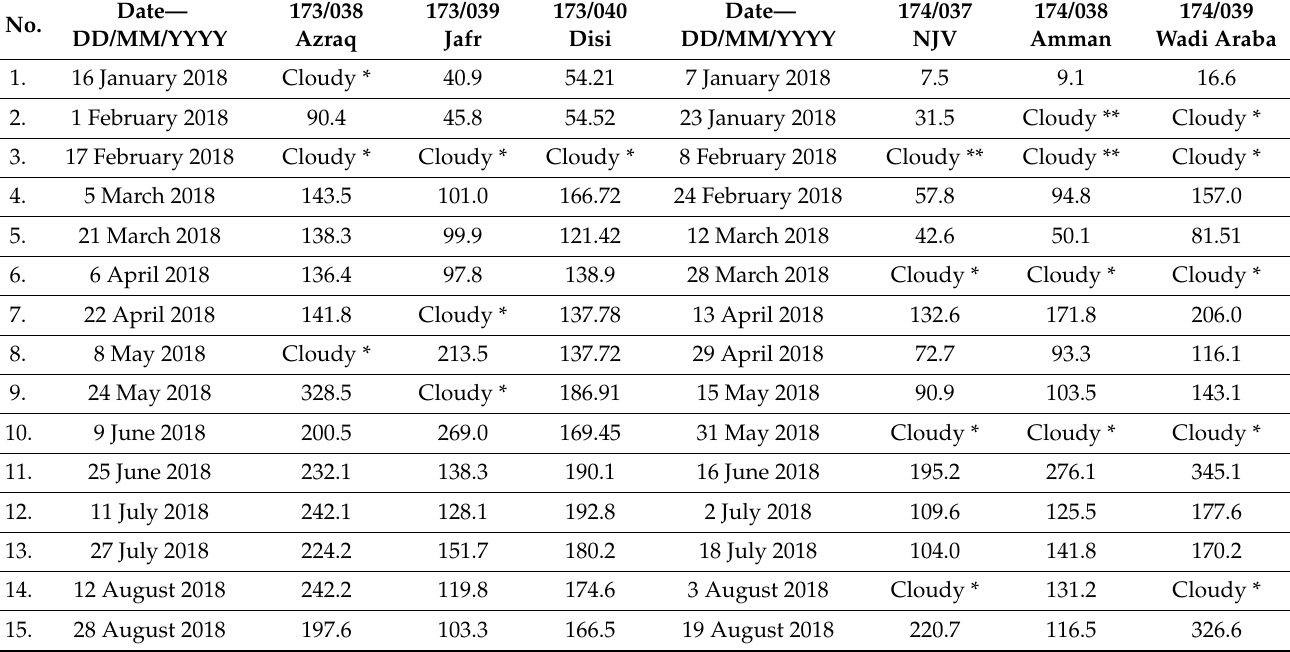
Table A1. Examples of Landsat 8 images used for mapping irrigated crops in 2018 and sum of ETr (mm) for the main irrigated area covered by each